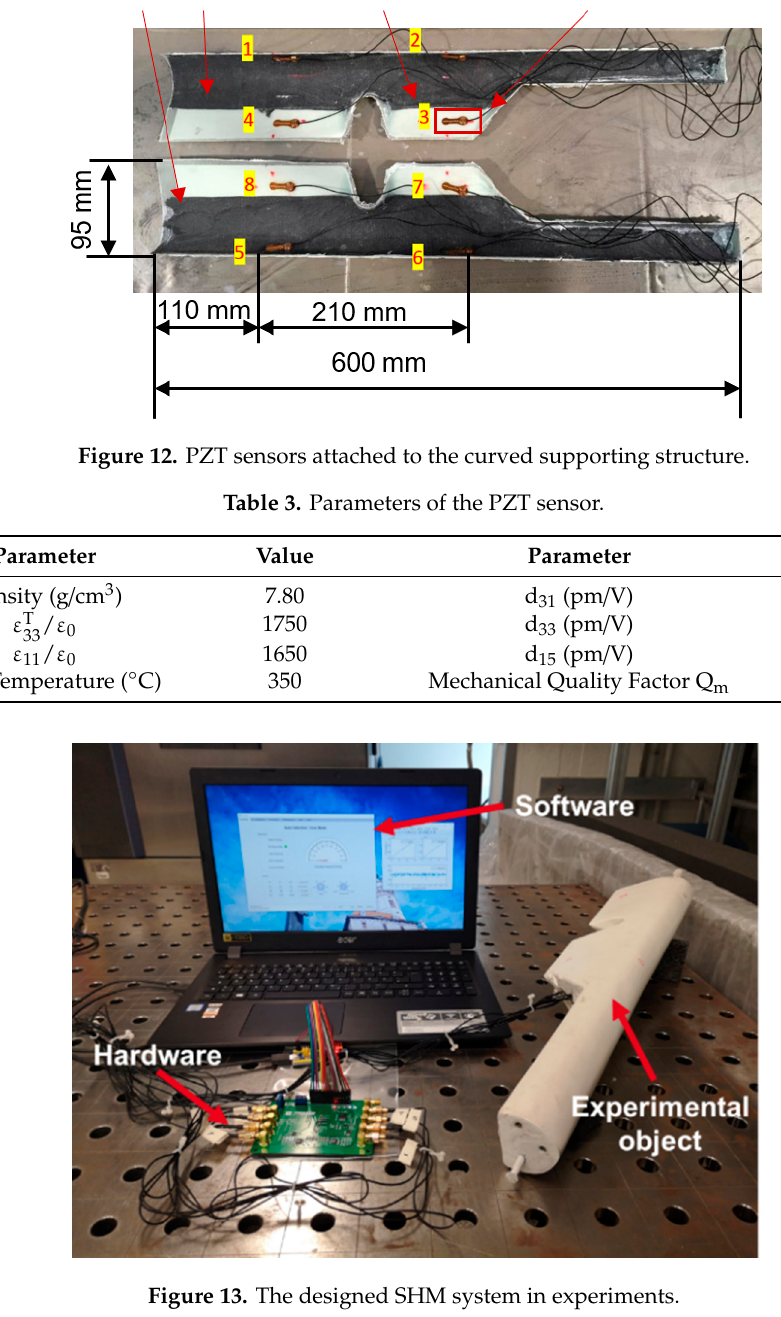
Figure 13. The designed SHM system in experiments.